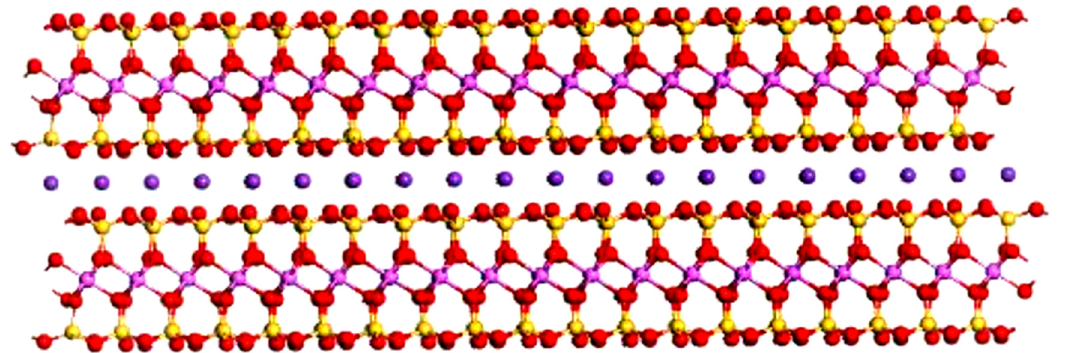
Figure 2. Schematic diagram of illite structure. The red particles are oxygen atoms, the yellow particles are silicon atoms, the pink particles are aluminum atoms, and the purple particles between layers are potassium ions.